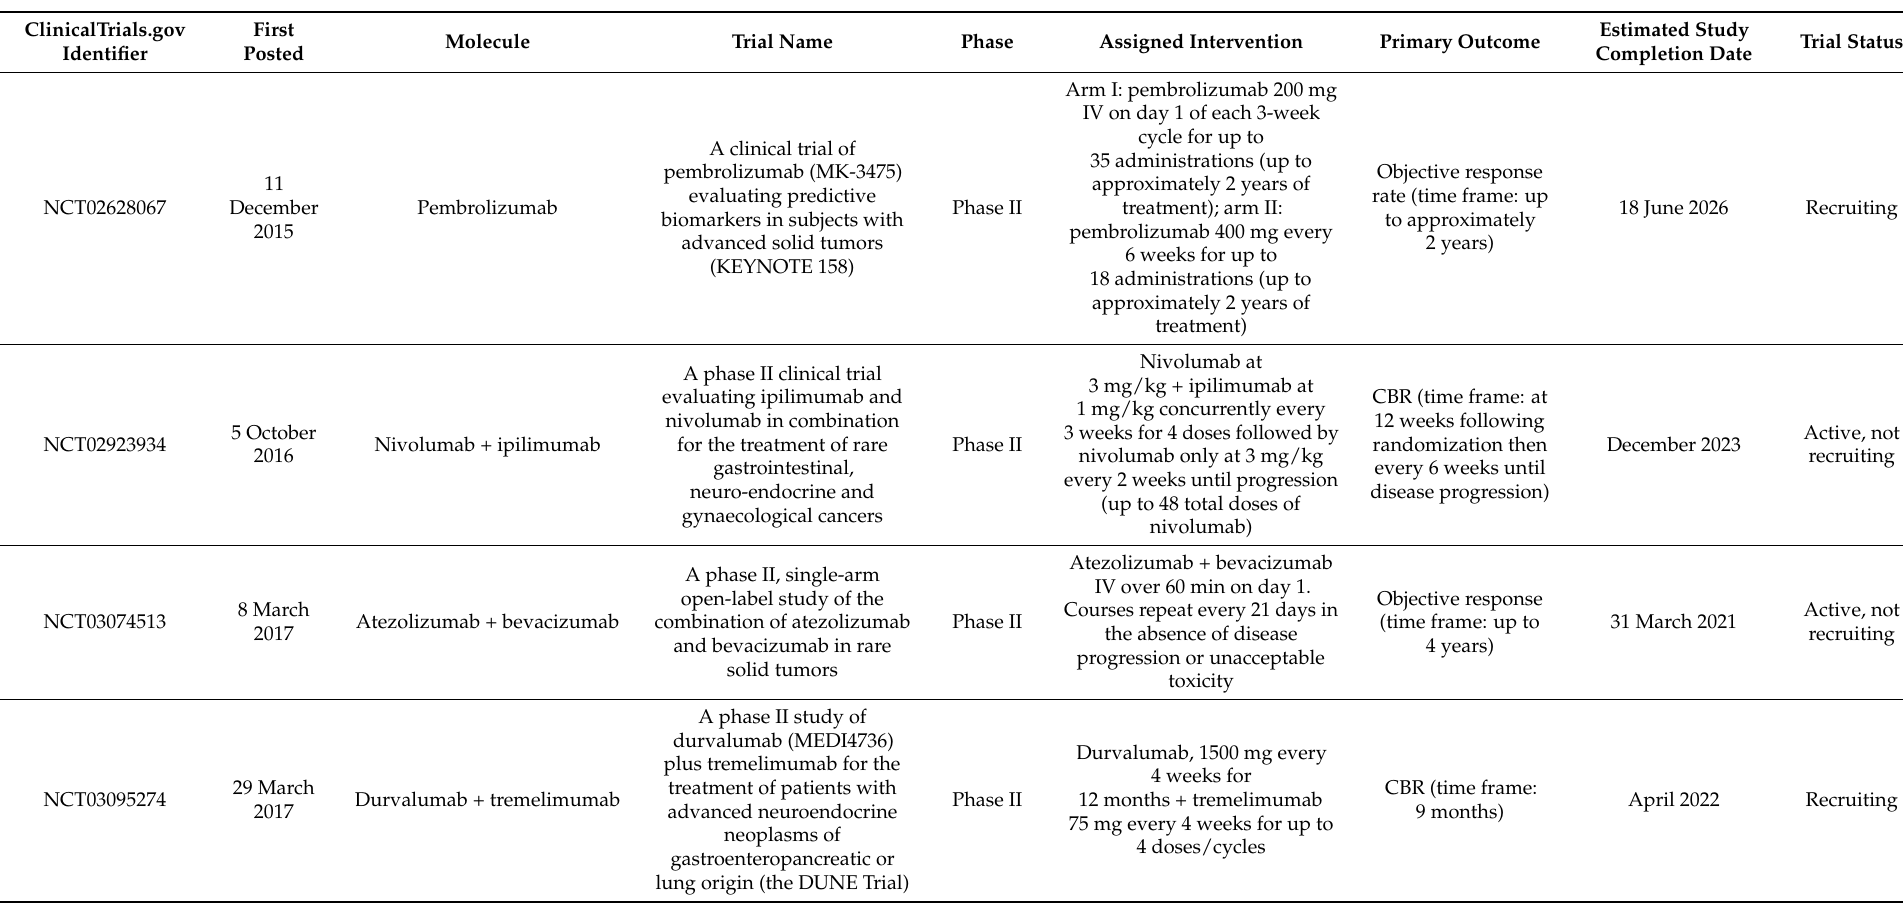
Table 2. Ongoing registered clinical trials of immune checkpoint inhibitors in advanced cancers that are expected to recruit patients with lung carcinoids. ClinicalTrials.gov